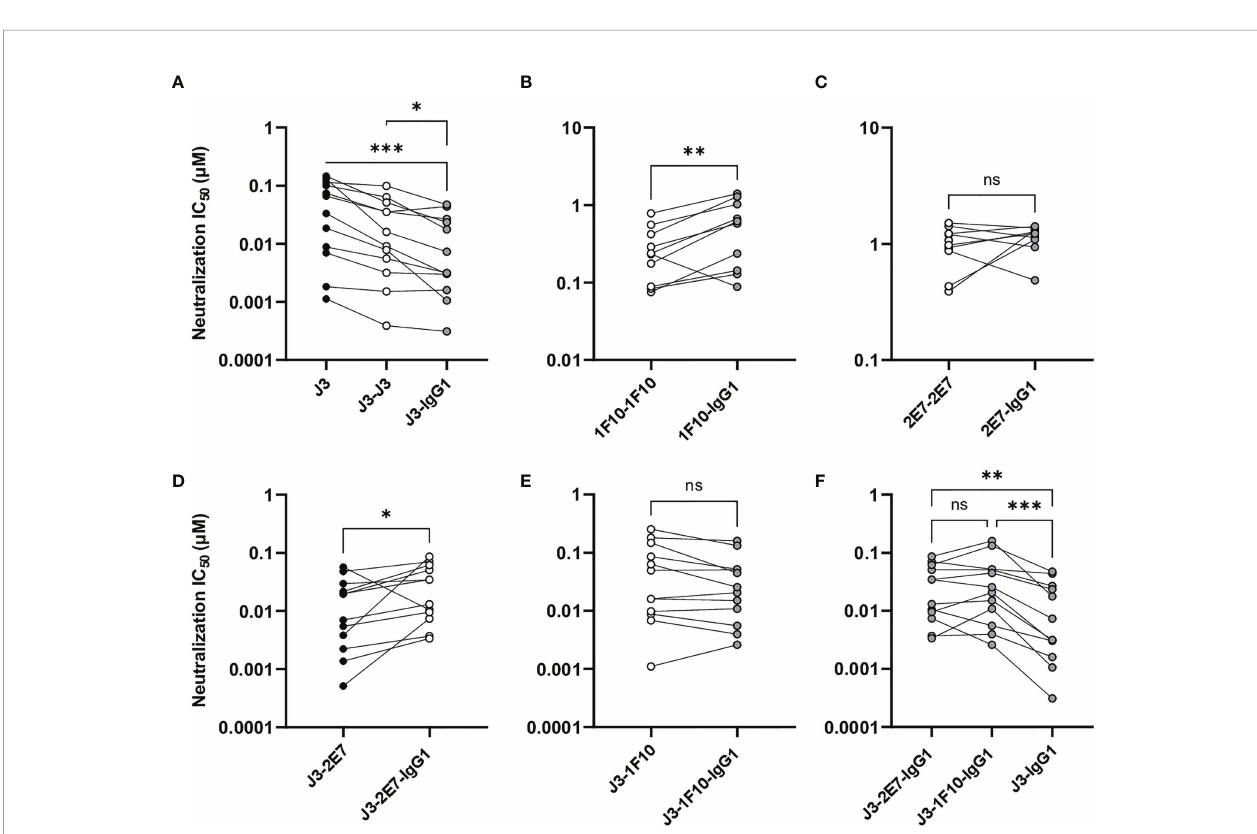
FIGURE 5 | Nanobody-IgG1 constructs are able to induce Fc-mediated effector functions. Neutralization capacity of IgG1 fusion constructs compared to monovalent or bivalent versions of (A) J3 (B) 1F10 and (C) 2E7 and (D) J3-2E7 and (E) J3-1F10. (F) Neutralization capacity of J3-IgG1 compared to bispeci fi c J3- 2E7-IgG1 and J3-1F10-IgG1. Friedman matched comparison was used to compare neutralization IC 50 (µM) between three groups. Wilcoxon matched-pairs signed rank tests was used to compare neutralization IC 50 (µM) between two groups. Signi fi cance is indicated as *p <0.05, **p <0.005, ***p <0.0005 and not signi fi cant (ns). Data shown are the average of three independent